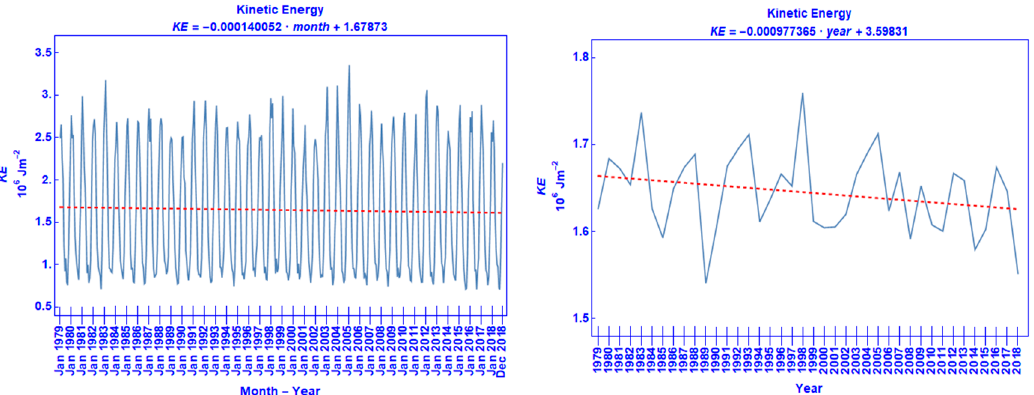
Figure 2. The course of the monthly means of the area average of KE from 1979 to 2018 ( left ) and the course of the annual means of the area average of KE from 1979 to 2018 ( right ). The red dashed line represents the linear regression fitted to the data; its mathematical formulation is shown on top.